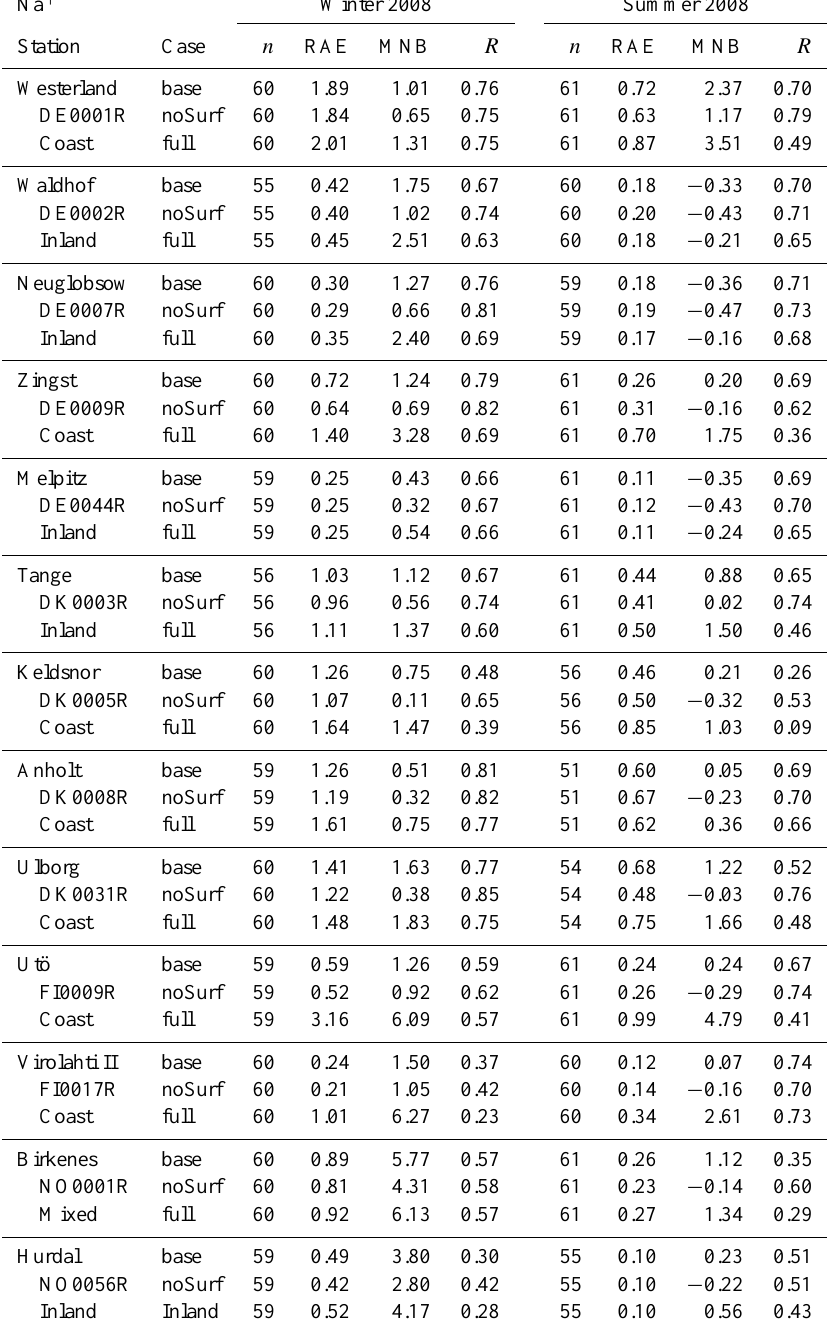
Table 2. Statistical values (RAE, MNB, and R ) for the comparison of measured and modeled (base and noSurf scenarios) sodium concen- trations at all considered stations (Fig. 2) and during two time periods (winter and summer